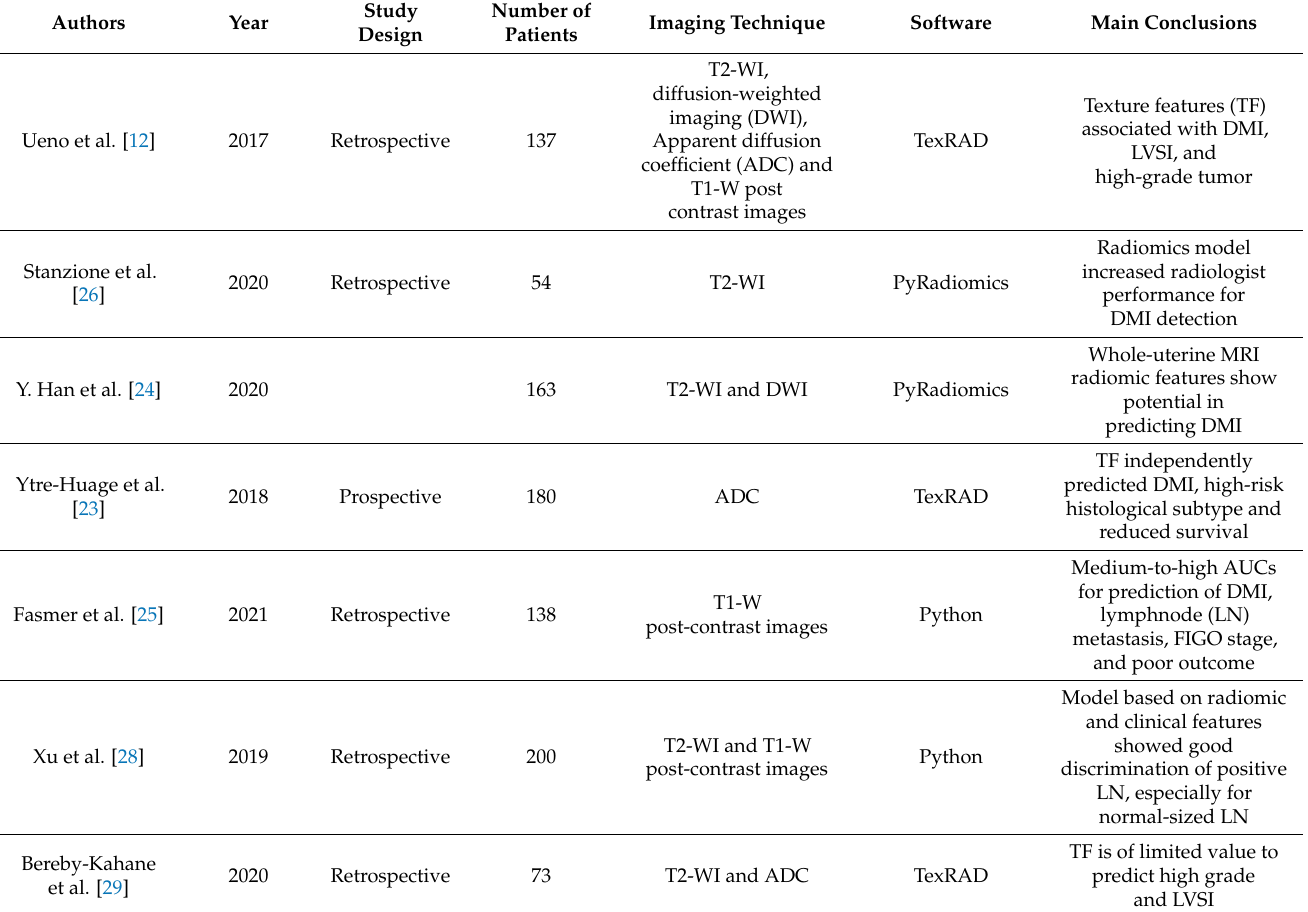
Table 4. Main information about the articles discussed and compared for assessment of radiomics in endometrial